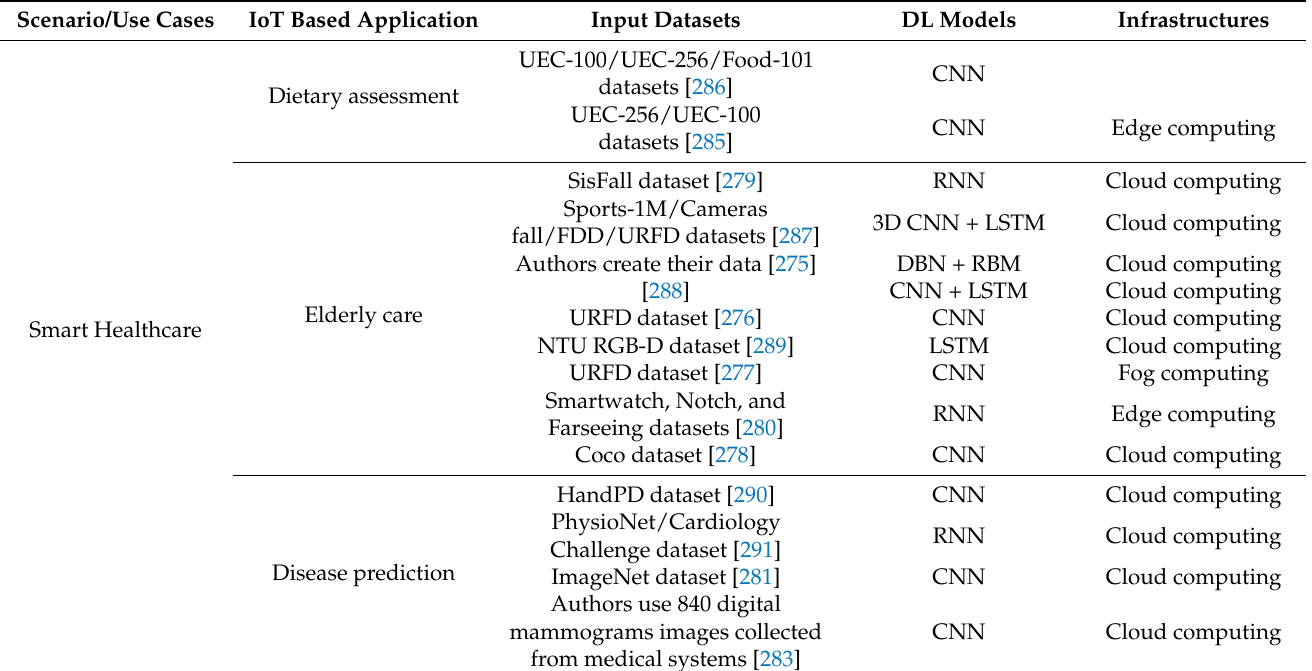
Table 6. Summary of Smart Healthcare Applications based on ML in